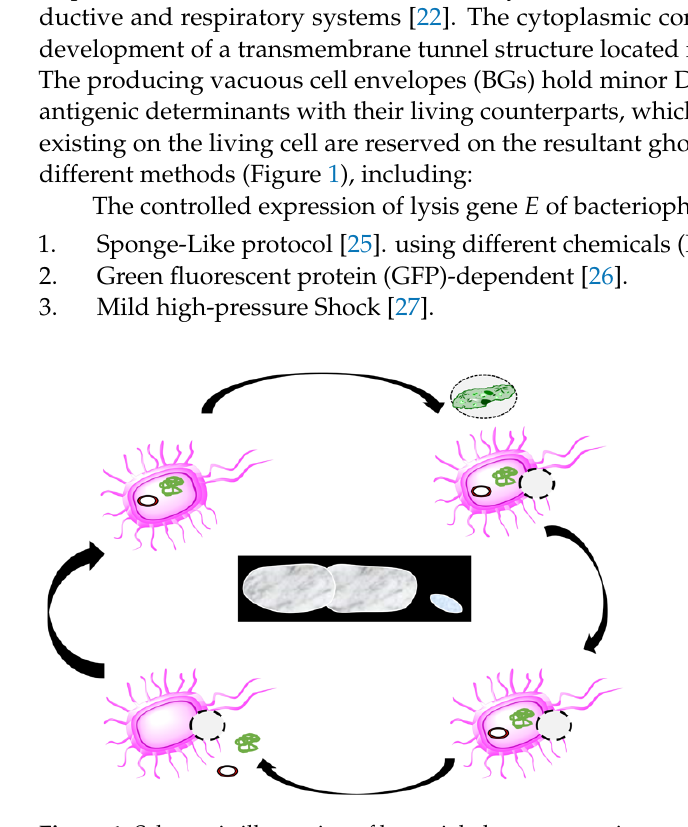
Figure 1. Schematic illustration of bacterial ghost preparations.